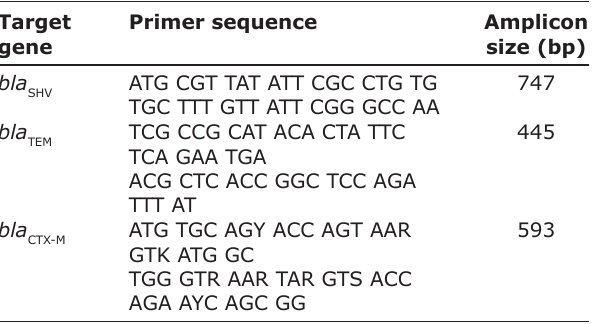
Table-1: Detail of the primers used in m-PCR amplification. Target Primer sequence gene